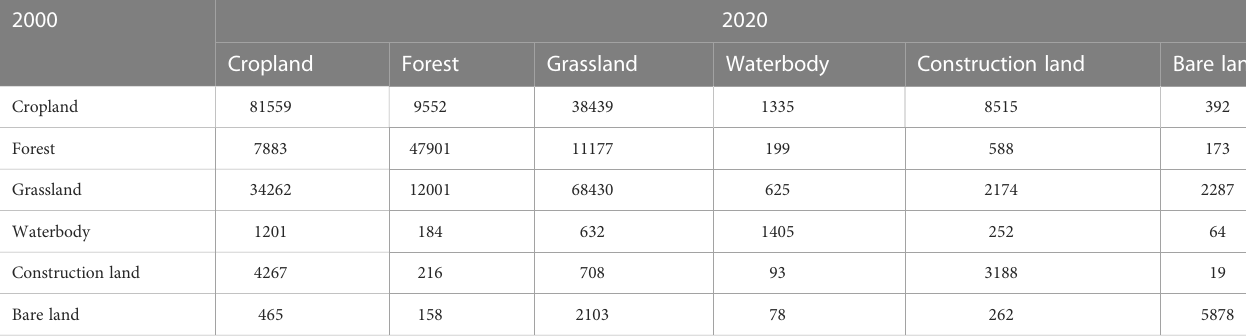
(Figure 6A). The spatial distribution of annual average temperature in the MRYR was signi fi cantly different, showing a general trend of high temperature in the east and low temperature in the west and high temperature in the south and low temperature in the north. The temperature in the west decreased while that in the east was increased from 2000 to 2020 (Figures 7A, 8A). The annual precipitation range of the MRYR was 507.5 – 858.6 mm. The highest precipitation